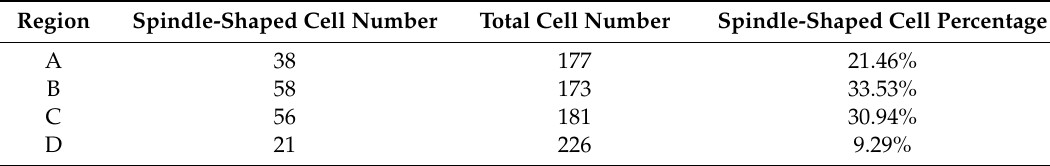
Table 1. Spindle-shaped cell number